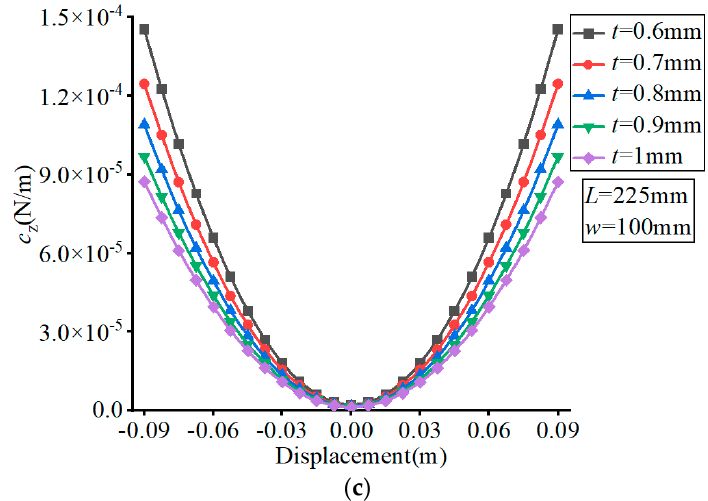
Figure 6. Effect of structural parameters on c z . ( a ) Effect of L ; ( b ) Effect of w ; ( c ) Effect of t .